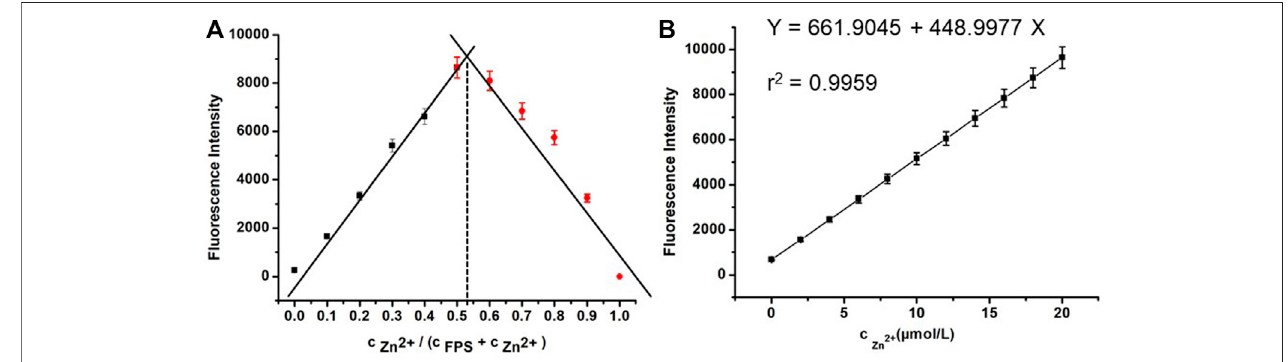
FIGURE4 |(A) The relationship between fl uorescence intensity of10.0 μ mol/L FPS and the time (B) Fluorescence spectra( λ ex (cid:2) 300 nm) of10.0 μ mol/LFPS and 10 μ mol/L Zn 2+ in the presence of Cu 2+ ion with various concentrations (from 0 to 5.0 μ mol/L) in methanol solution.